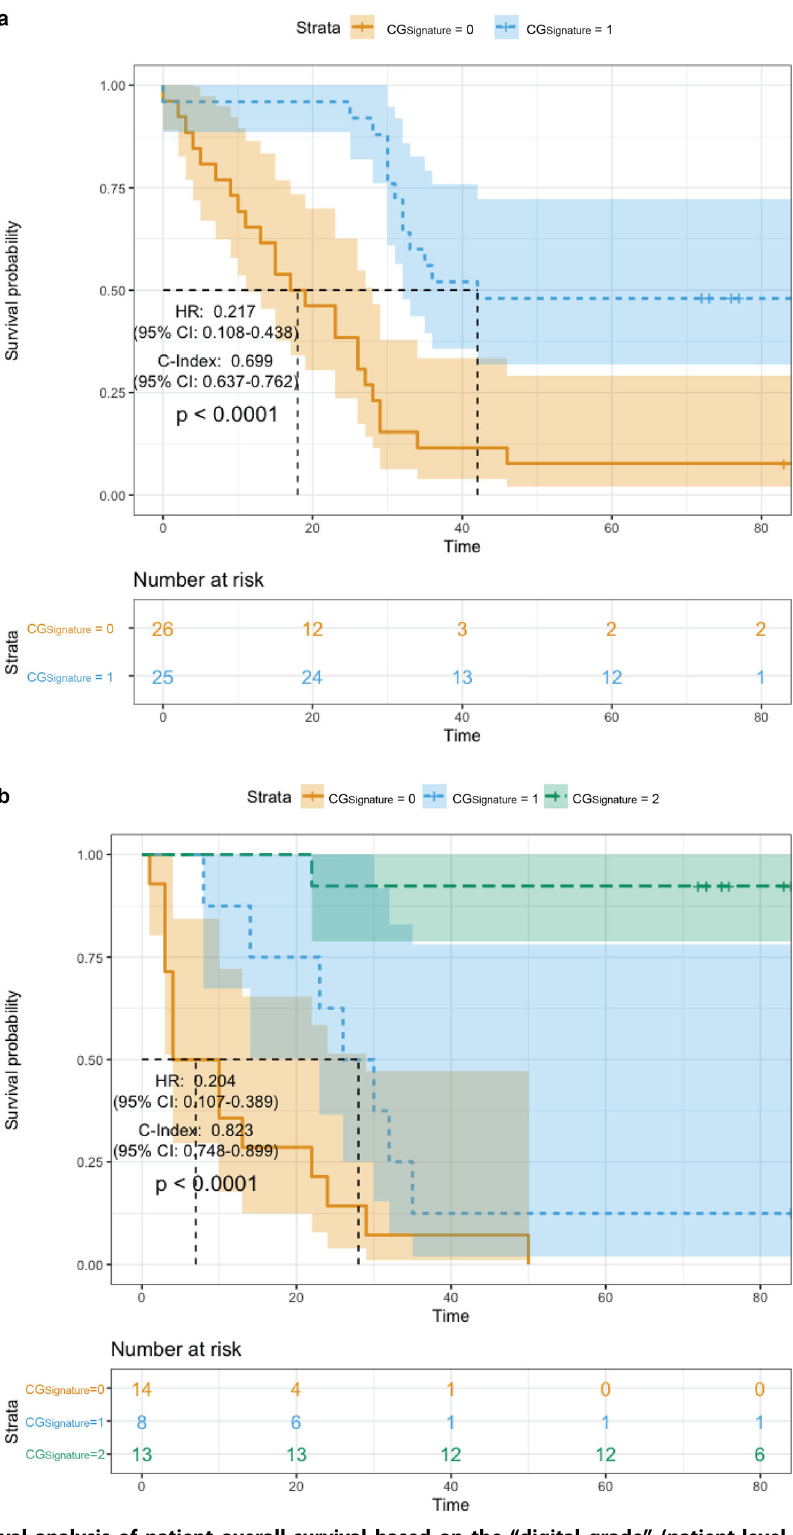
Fig. 4 Kaplan – Meier survival analysis of patient overall survival based on the “ digital grade ” (patient-level predictions) produced by CG Signature . a Kaplan – Meier survival analysis results based on the binary-classi fi cation. b Kaplan – Meier survival analysis results based on the ternary classi fi